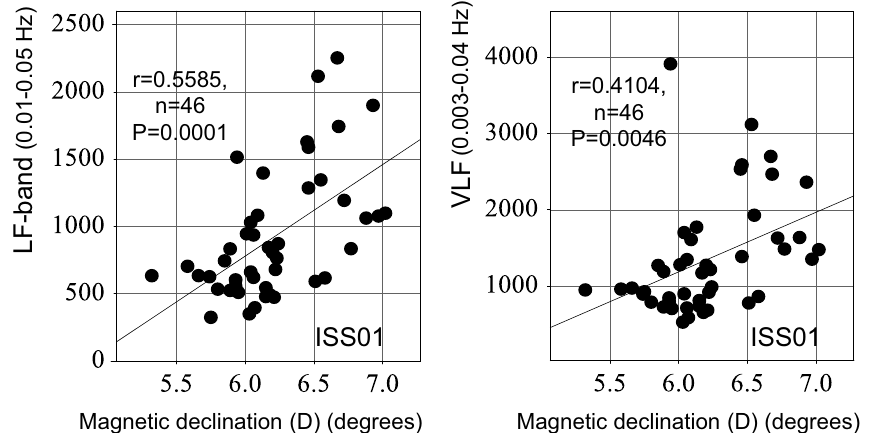
Figure 2. Effects of magnetic fluctuations on the ISO, LF-band and VLF-component. Magnetic declination (D) positively affects the LF-band (r = 0.5585, P = 0.0001) (left) and the VLF-component (r = 0.4104, P = 0.0046) (right) during ISS01, suggesting that the activation of the brain’s DMN by magnetic fluctuations may play an important role for improving the “intrinsic” cardiovascular regulatory system (β) in space. Pearson’s correlation coefficients computed from hourly averages of magnetic declination (D) and ISOs (LF-band and VLF component of HRV) in order to eliminate or at least reduce serial